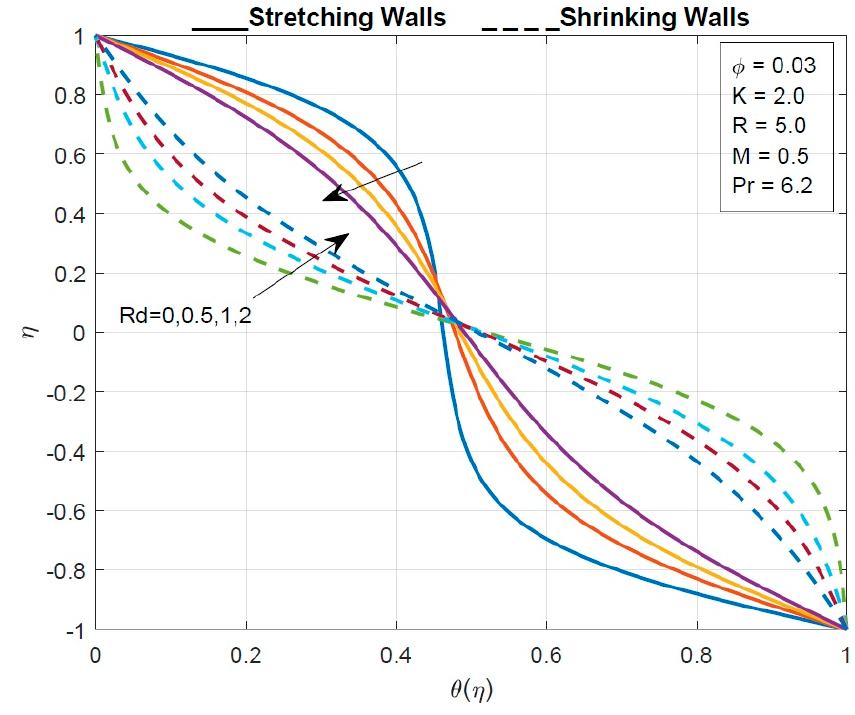
Figure 12. T he effect of the radiation parameter on the temperature profile. Figure 12. The effect of the radiation parameter on the temperature profile.